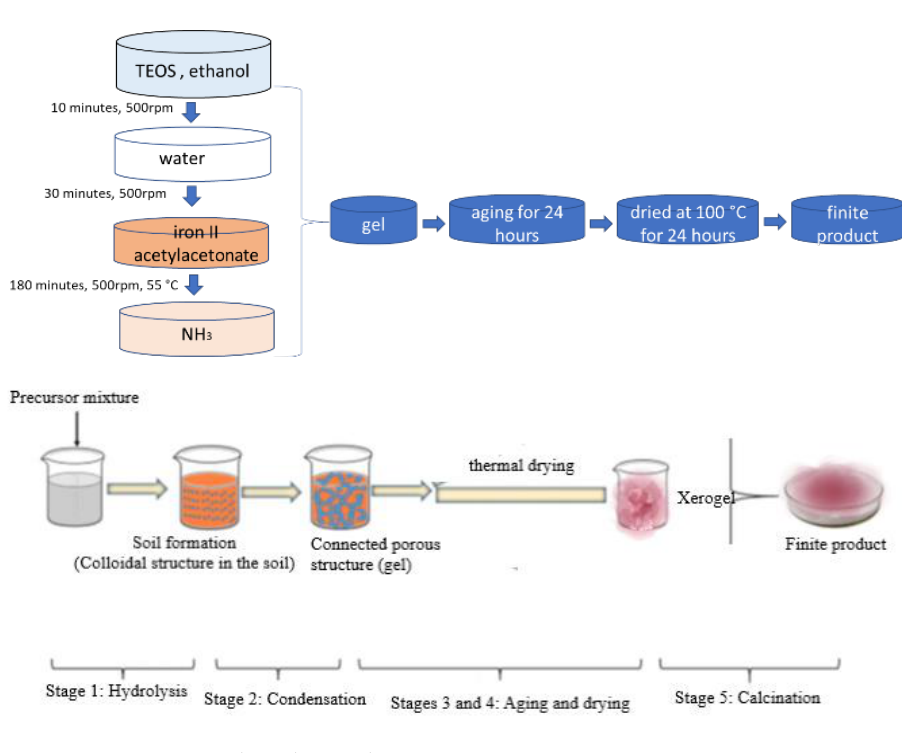
Figure 1. SiO 2 Fe x O y xerogel synthesis scheme.